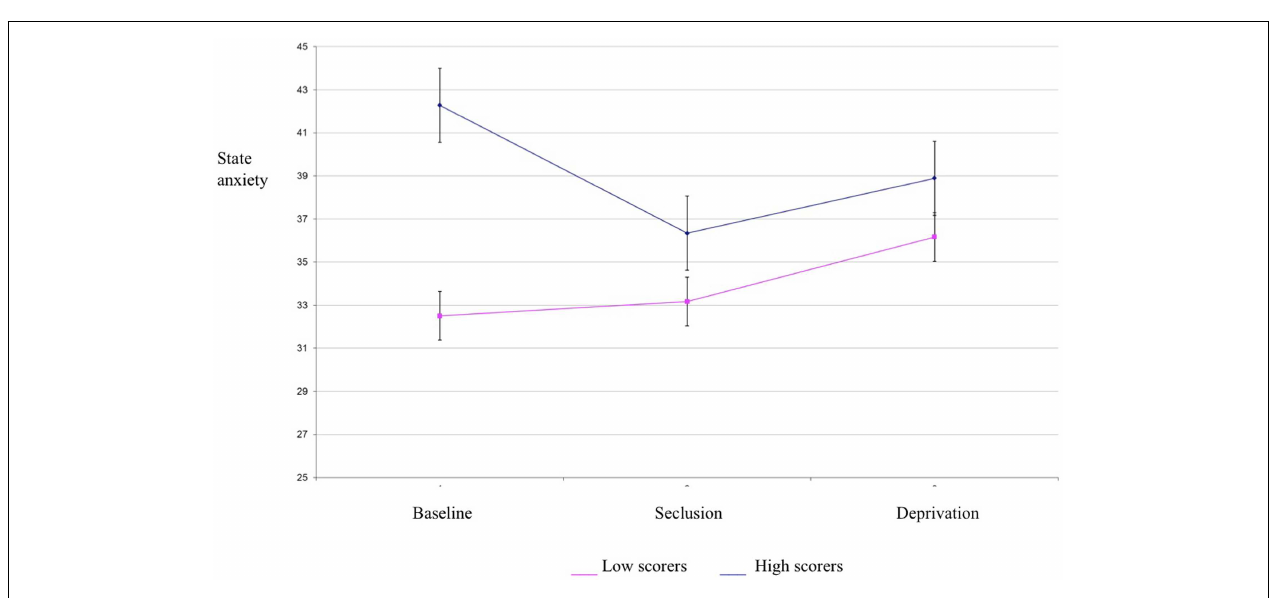
FIGURE 2 | State anxiety scores in high and low hallucination-prone groups by condition .